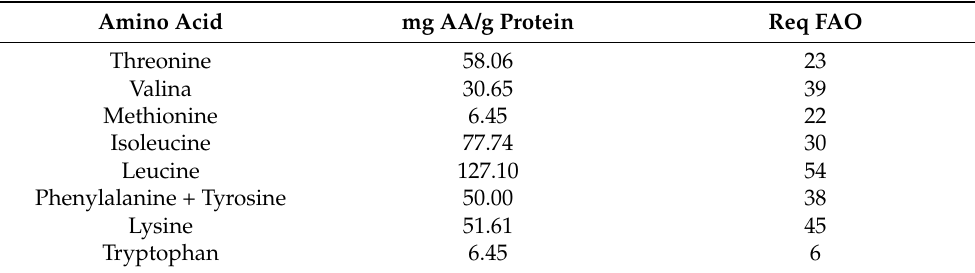
Table 6. Comparison of the amino acid intake of hamburger (M05) with the proposed FAO require-